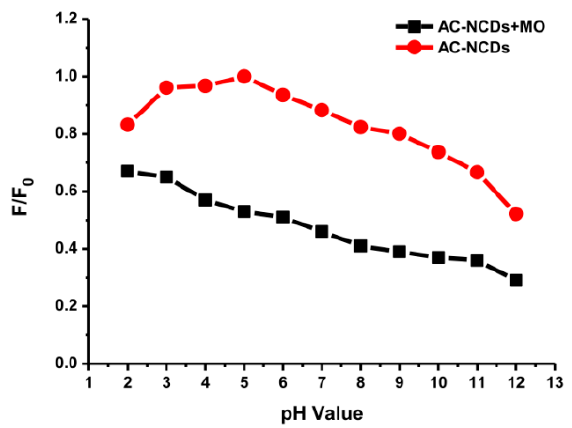
Figure 10. Fluorescence intensity of AC-NCDs and AC-NCDs/MO system with different pH